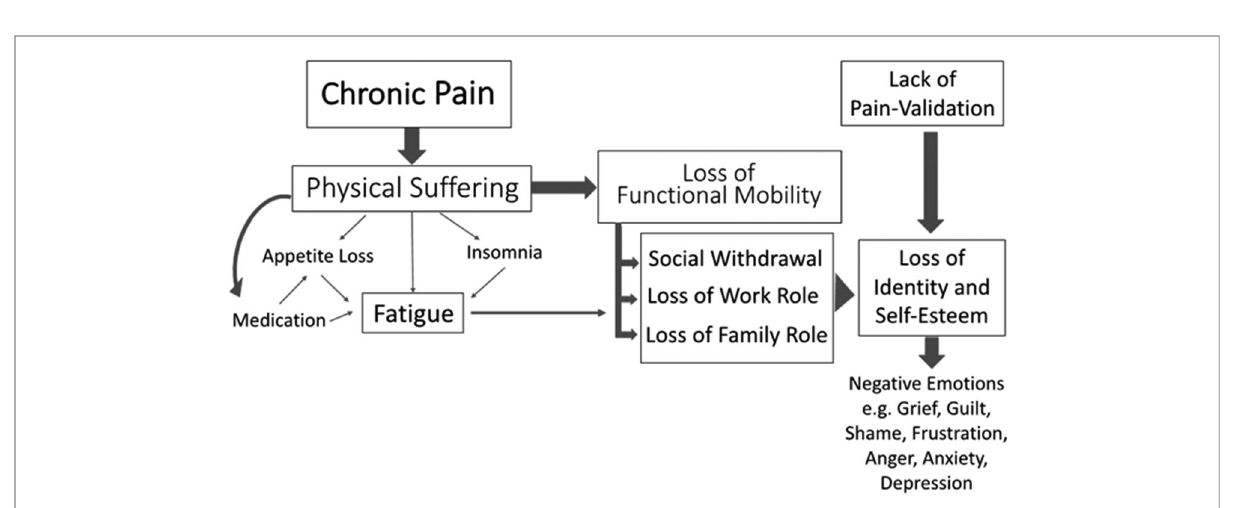
FIGURE 2 A holistic representation of chronic pain and commonly experienced